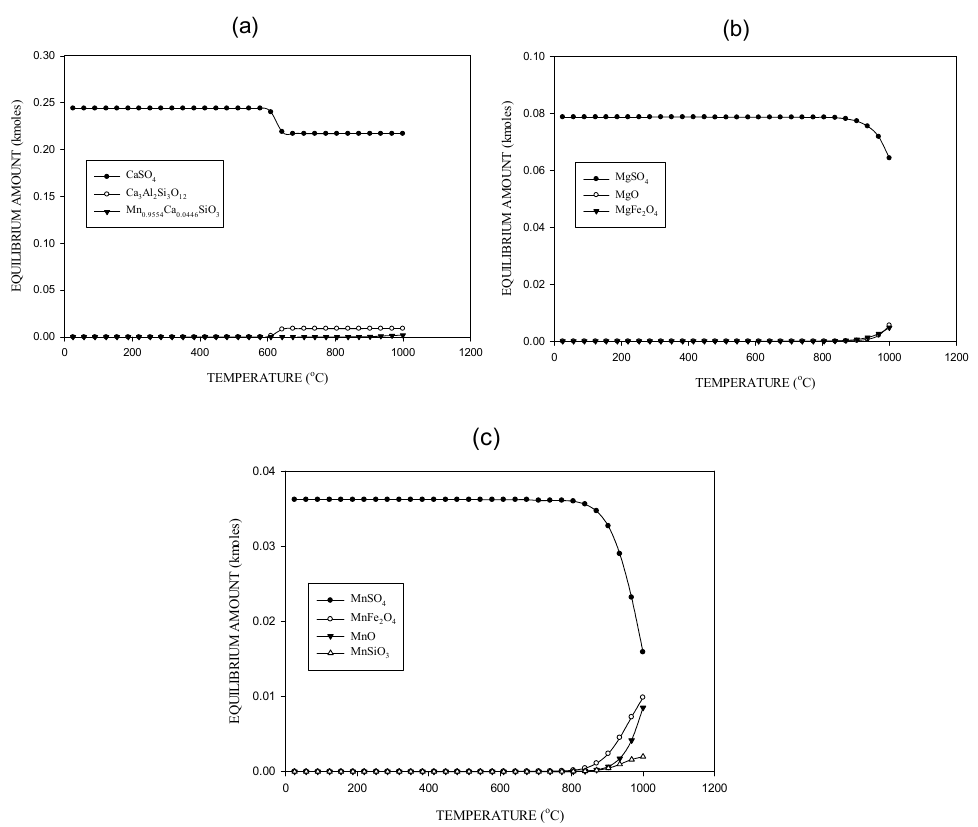
Figure 6. ( a ) Behaviour of calcium-containing species as a function of temperature for a sulphur dioxide addition of 0.68 kmole/100 kg of dust and 0.4 kmole of oxygen/100 kg of dust. ( b ) Behaviour of magnesium-containing species as a function of temperature for a sulphur dioxide addition of 0.68 kmole/100 kg of dust and 0.4 kmole of oxygen/100 kg of dust. ( c ) Behaviour of manganese-containing species as a function of temperature for a sulphur dioxide addition of 0.68 kmole/100 kg of dust and 0.4 kmole of oxygen/100 kg of dust.